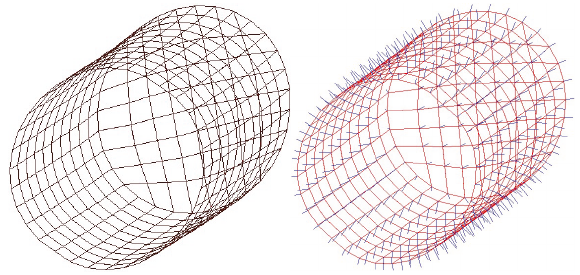
Figure 11: Fourth excavation and blasting seismic wave